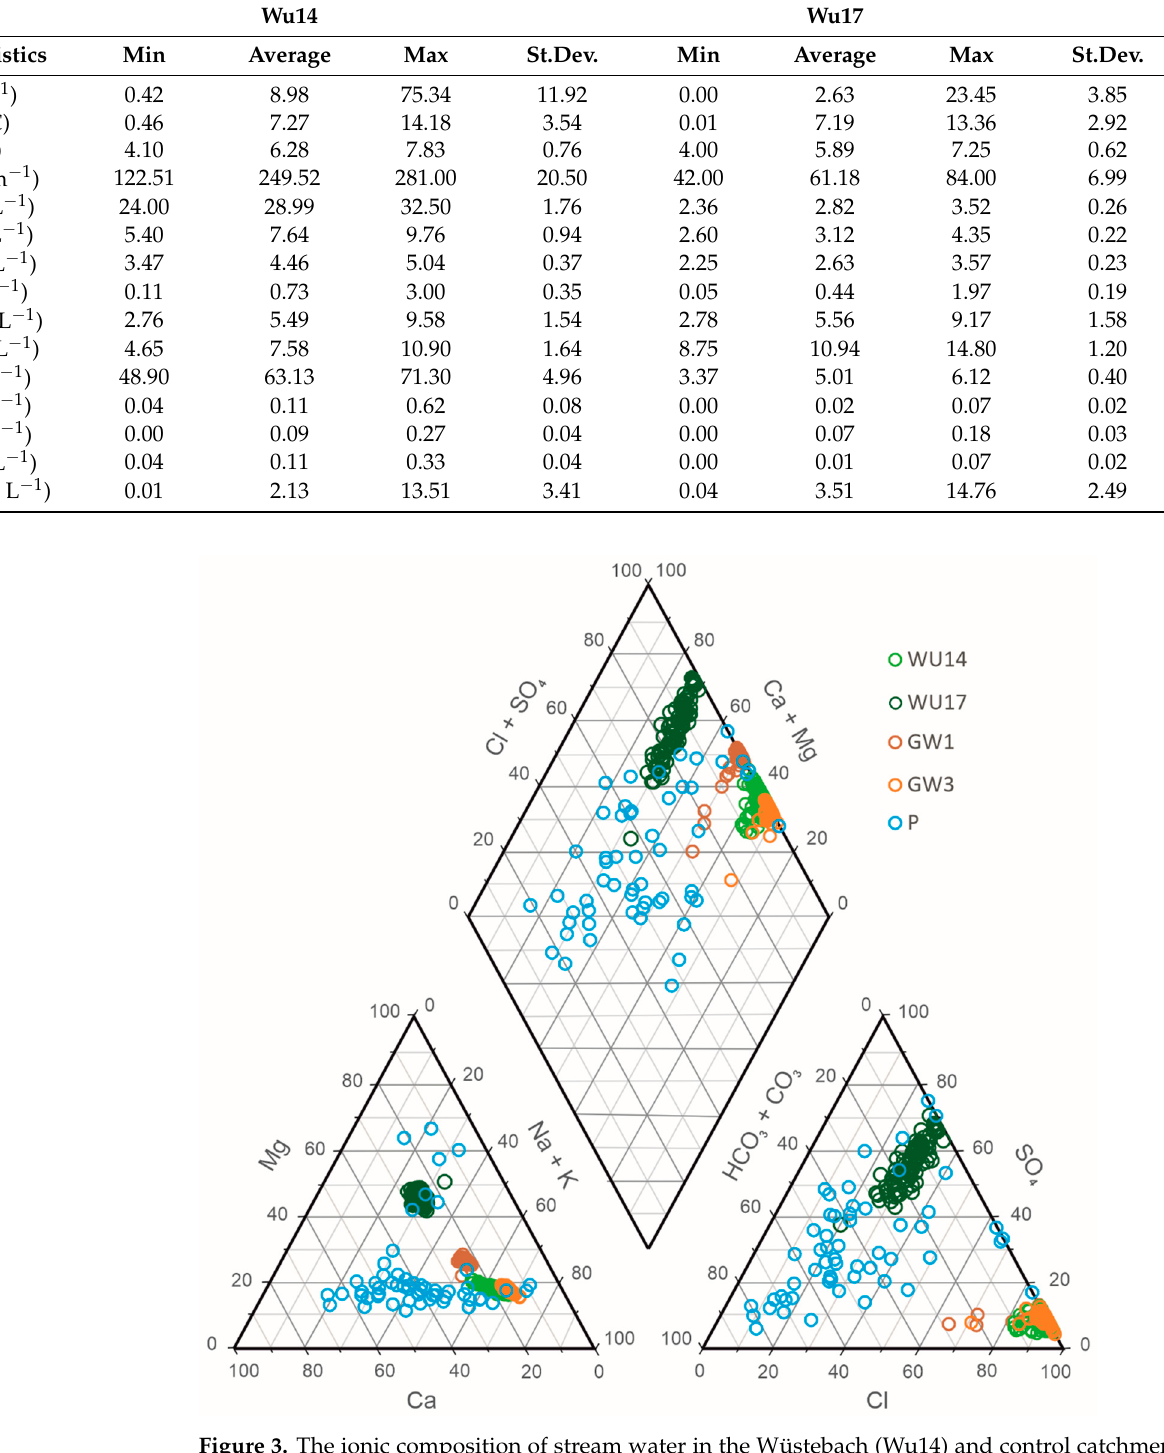
Table 1. Physical and chemical characteristics of stream water in the Wüstebach (Wu14) and the control catchment (Wu17) in the pre-deforestation period.